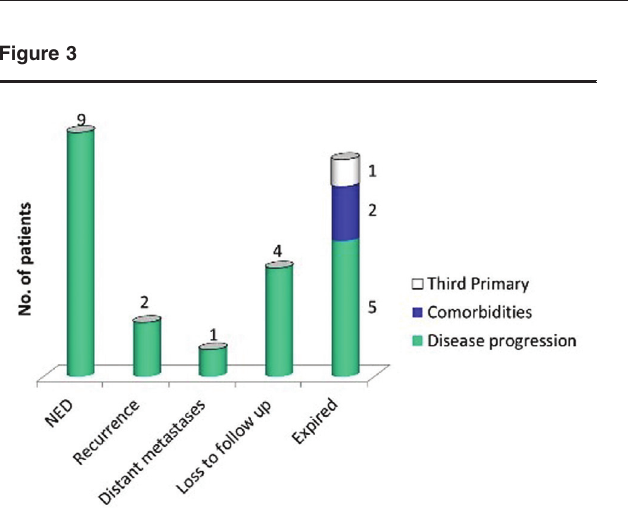
Setup verification by cone beam